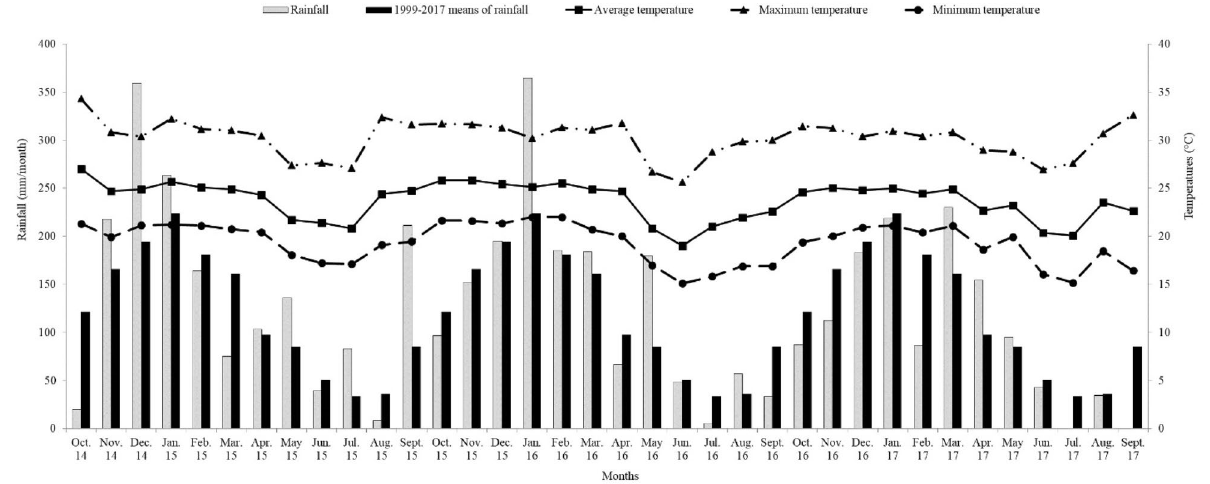
Figure 4. Monthly rainfall and minimum, average and maximum temperatures from September 2011 to July 2012, and historical 18-year (1999–2017) means of rainfall and medium